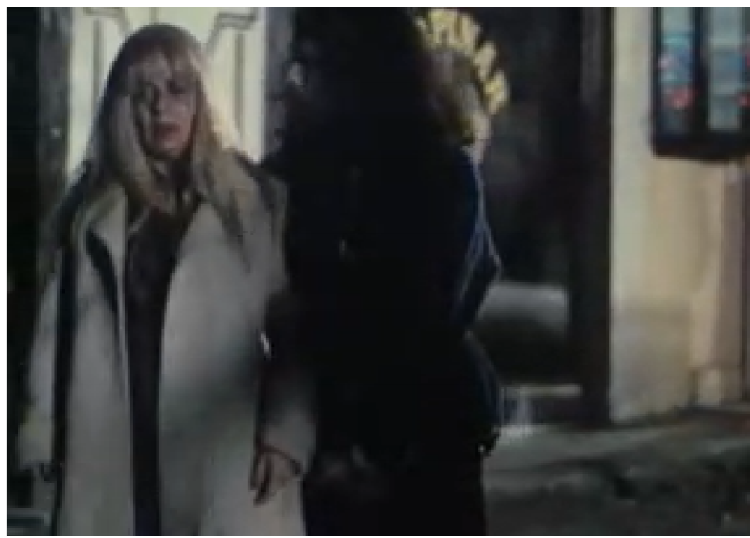
Figure 10: Melek (Deniz Türkali) is desperate after she argues with her